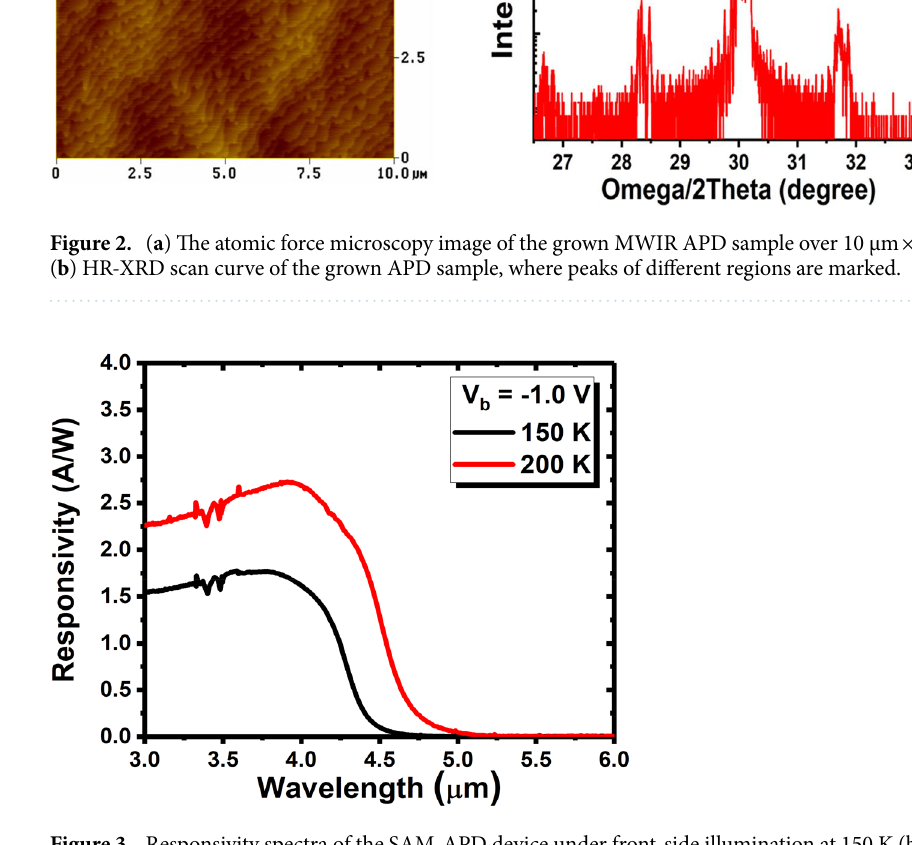
Figure 3. Responsivity spectra of the SAM-APD device under front-side illumination at 150 K (black) and 200 K (red) under − 1.0 V bias